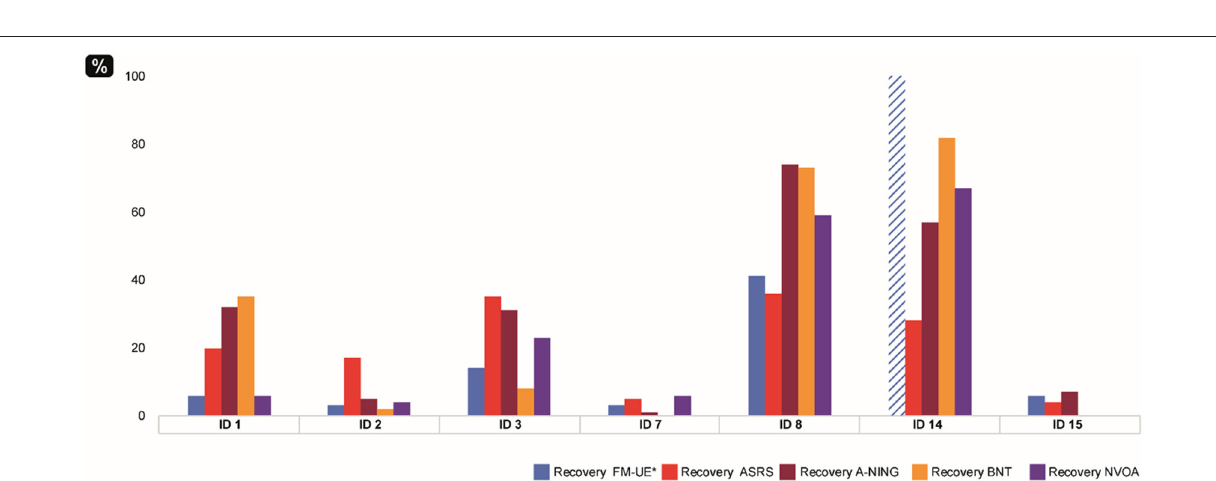
Frontiers in Neurology |